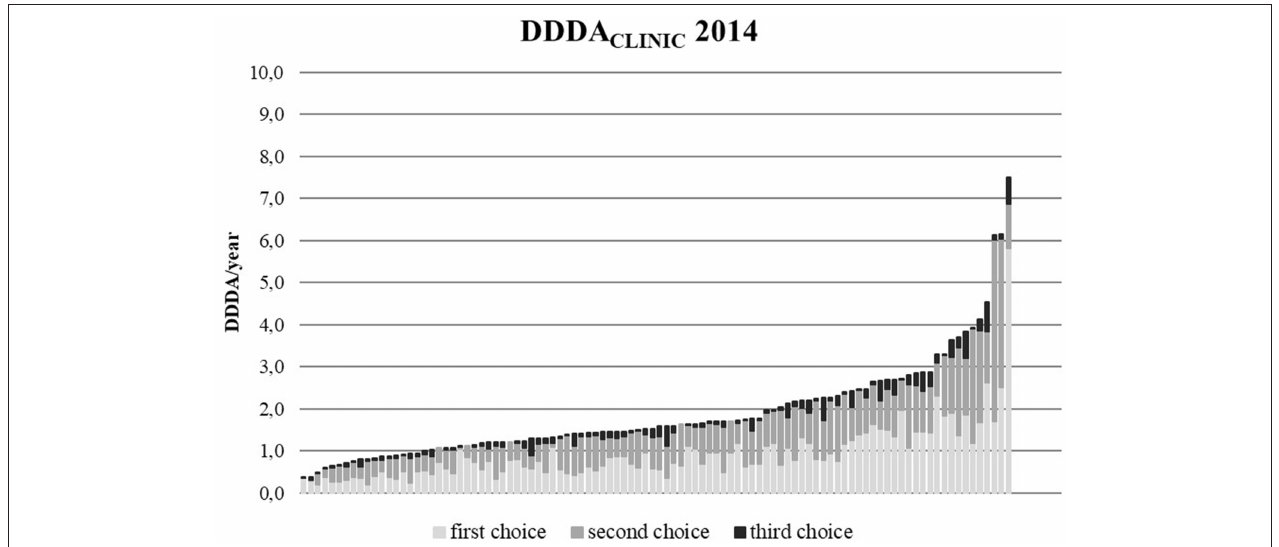
FIGURE 4 | DDDA CLINIC figures for all 100 clinics in 2014, specified for first, second, and third choice antimicrobials, showing the differences in AMU between clinics (based upon procurement data of these 100